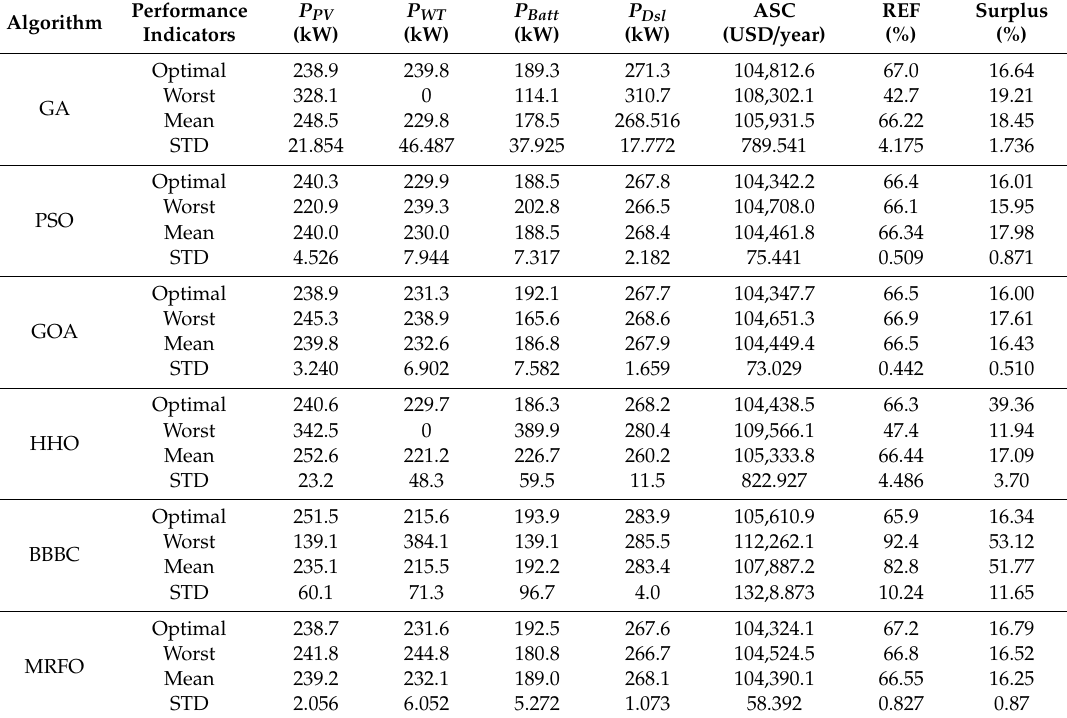
Table 4. Simulation results for loss of power supply probability (LPSP) = 0% considering 50 total runs. Algorithm